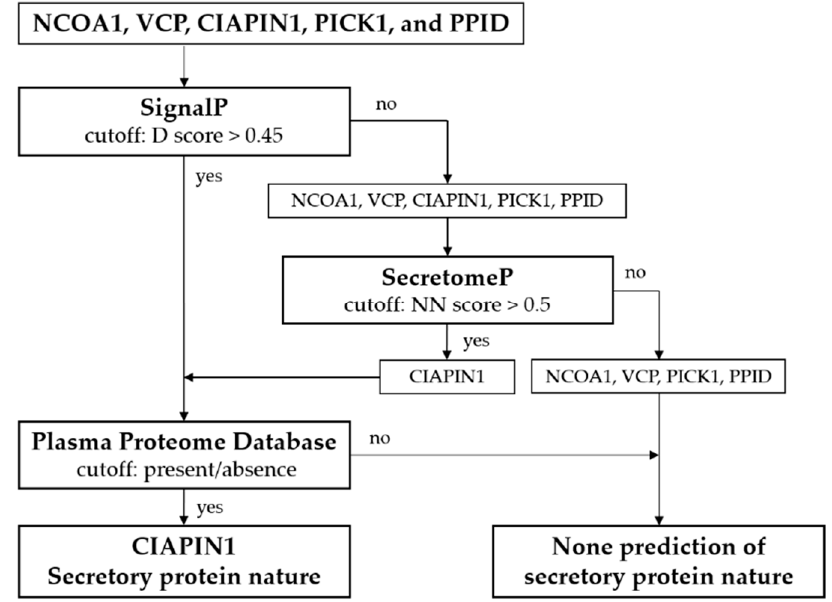
Figure 3. Bioinformatic analysis of secretory proteins identified uniquely CIAPIN1 as a secreted Figure protein.